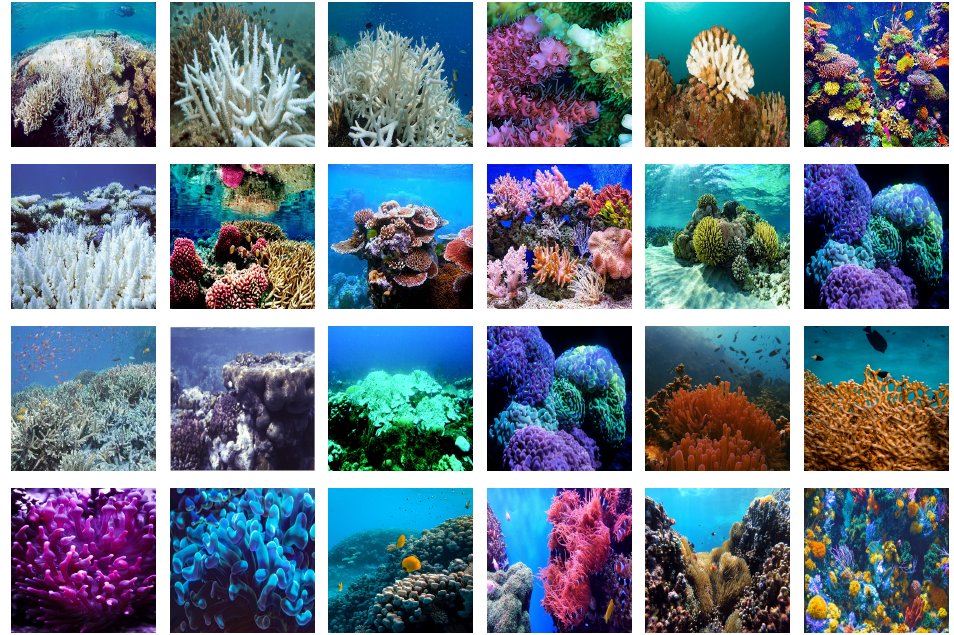
Figure 8. Sample patches of images of dataset.